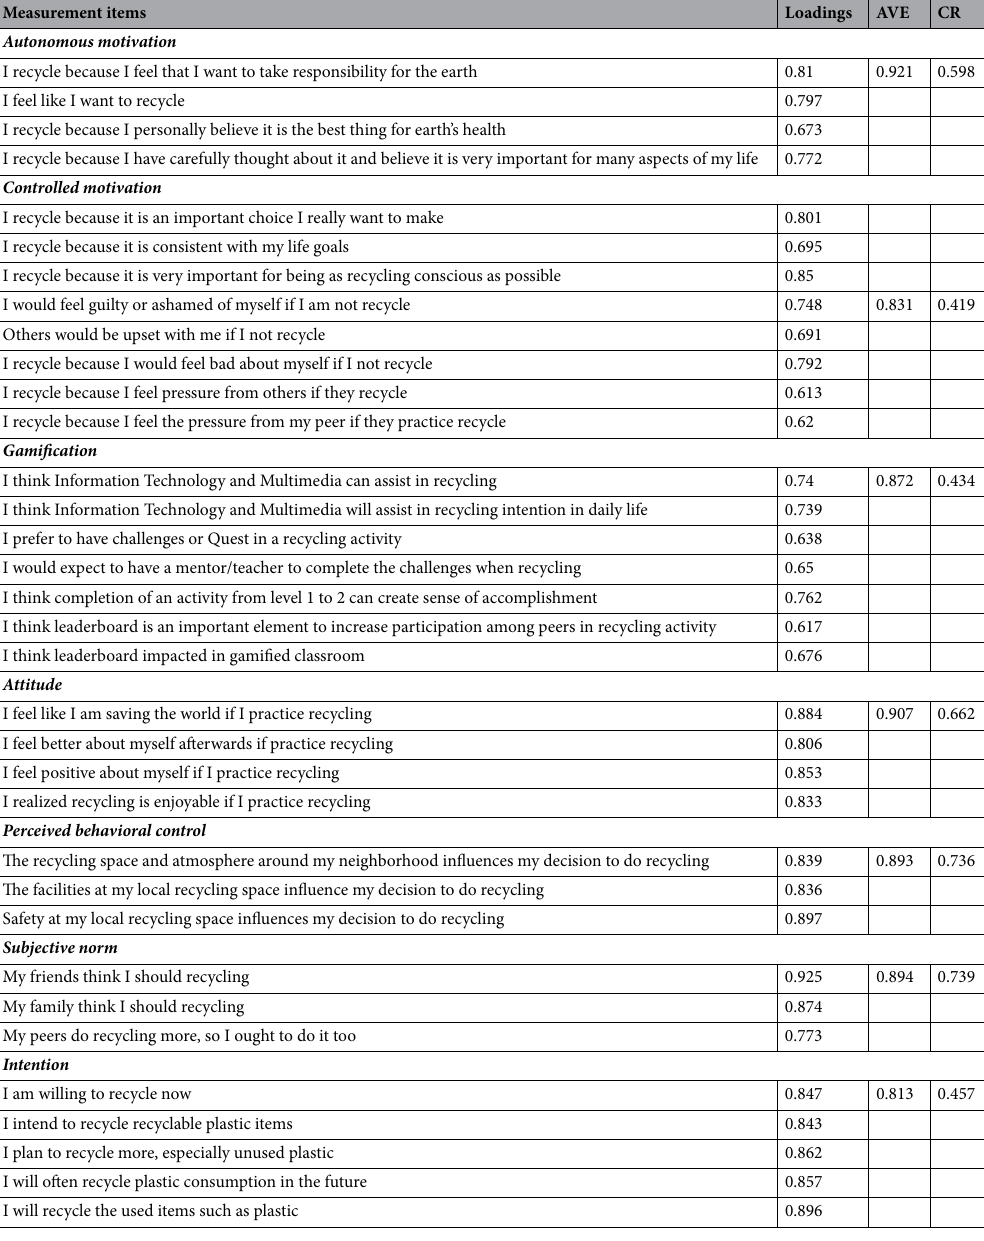
Table 2. Validity and Reliability of